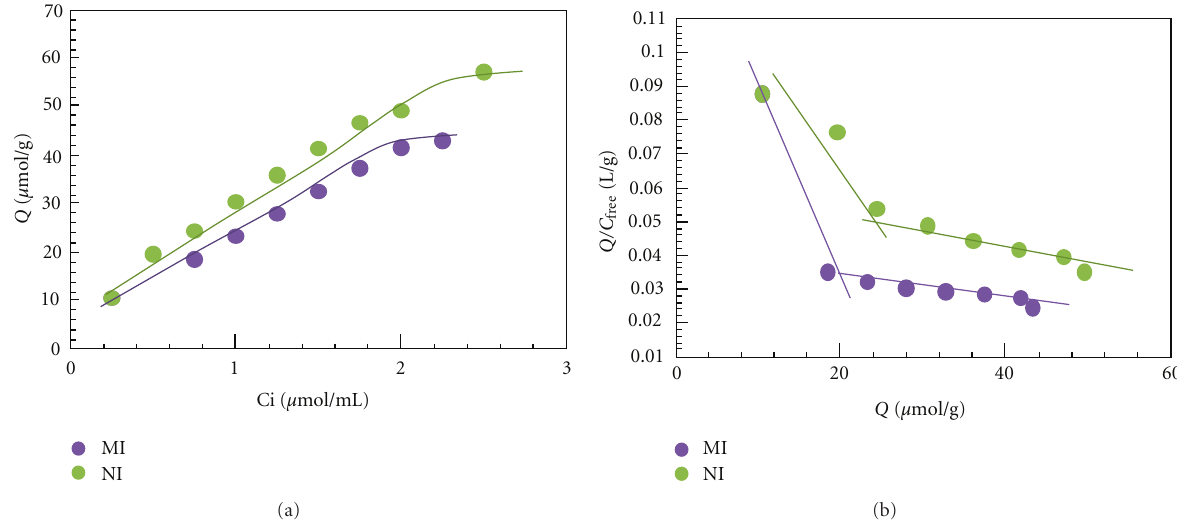
Figure 2: Binding isotherm (a) and Scatchard plot (b) for the Ferroin-imprinted (MI) or nonimprinted (NI) polymer. Q = Ferroin bound to 50.0 mg of the corresponding polymer; temperature = 25 ◦ C; volume = 4.00 mL; binding time: 12h.